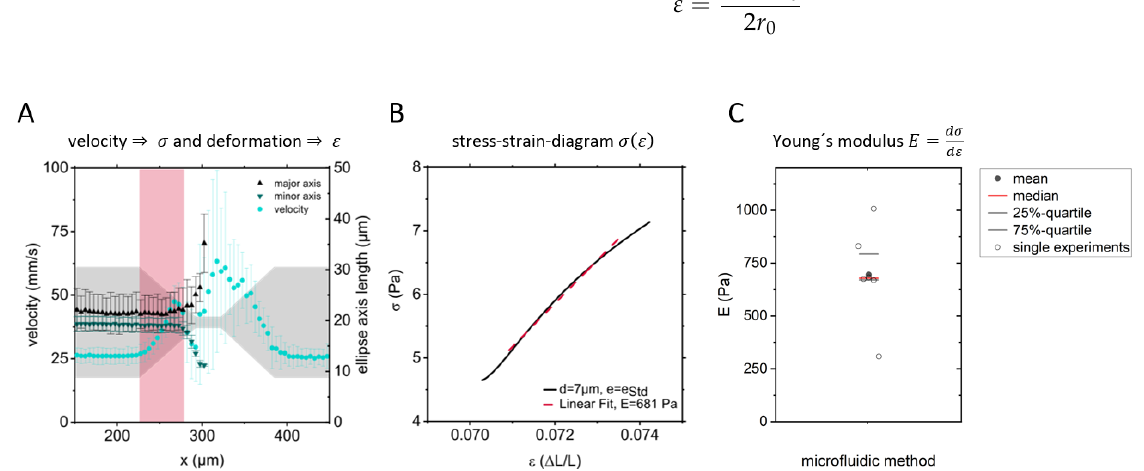
Figure 5. ( A ) Velocity, major and minor ellipse axes from one measurement as function of the position x. Mean and standard deviation from 2300 cell trajectories. ( B ) Stress–strain diagram and linear fit to determine the Young’s modulus of one set of A375 cells. ( C ) Resulting Young’s moduli from six independent measurements as shown in B, representing about 2500 cells each.